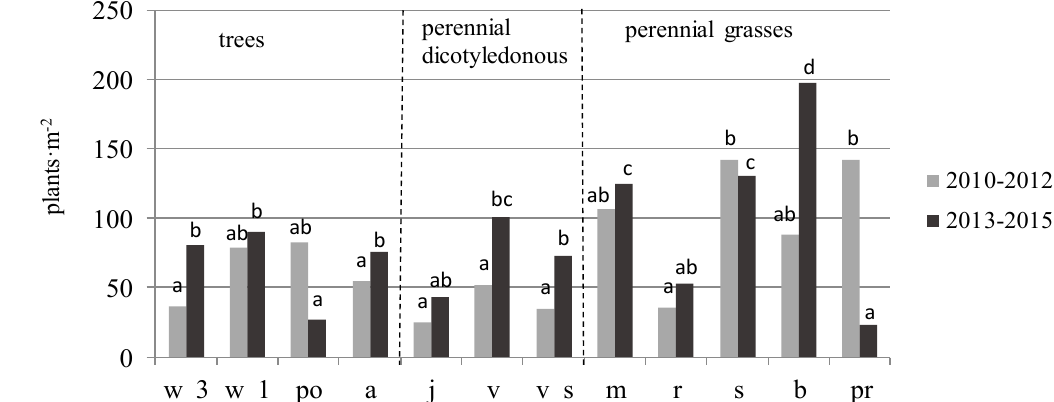
Figure 3. Weed flora density on energy crops plantations in 2010 ‒ 2012 and 2013 ‒ 2015. Means for three years are presented in each column ( n = 3 years × 4 replications = 12). Within each dataset, different letters represent significantly different values according to the Kruskal ‒ Wallis test ( p ≤ 0.05).